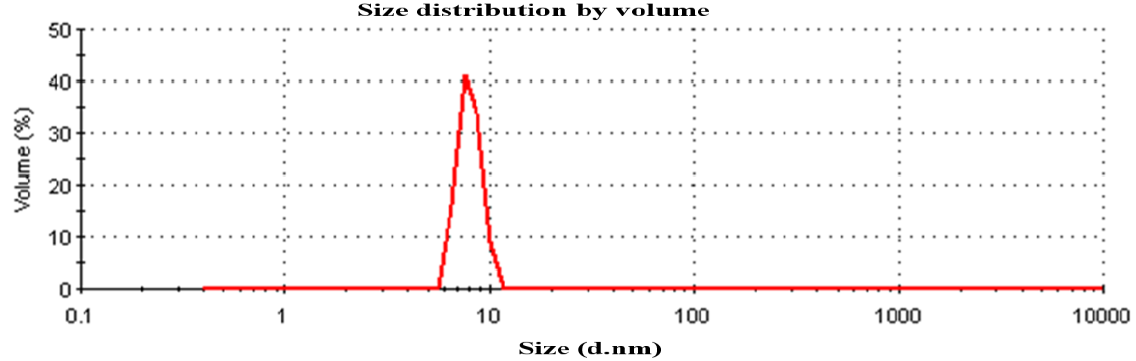
Figure 5. Plant NC Particle size diluted with water and treated with ultrasound for 20 min.